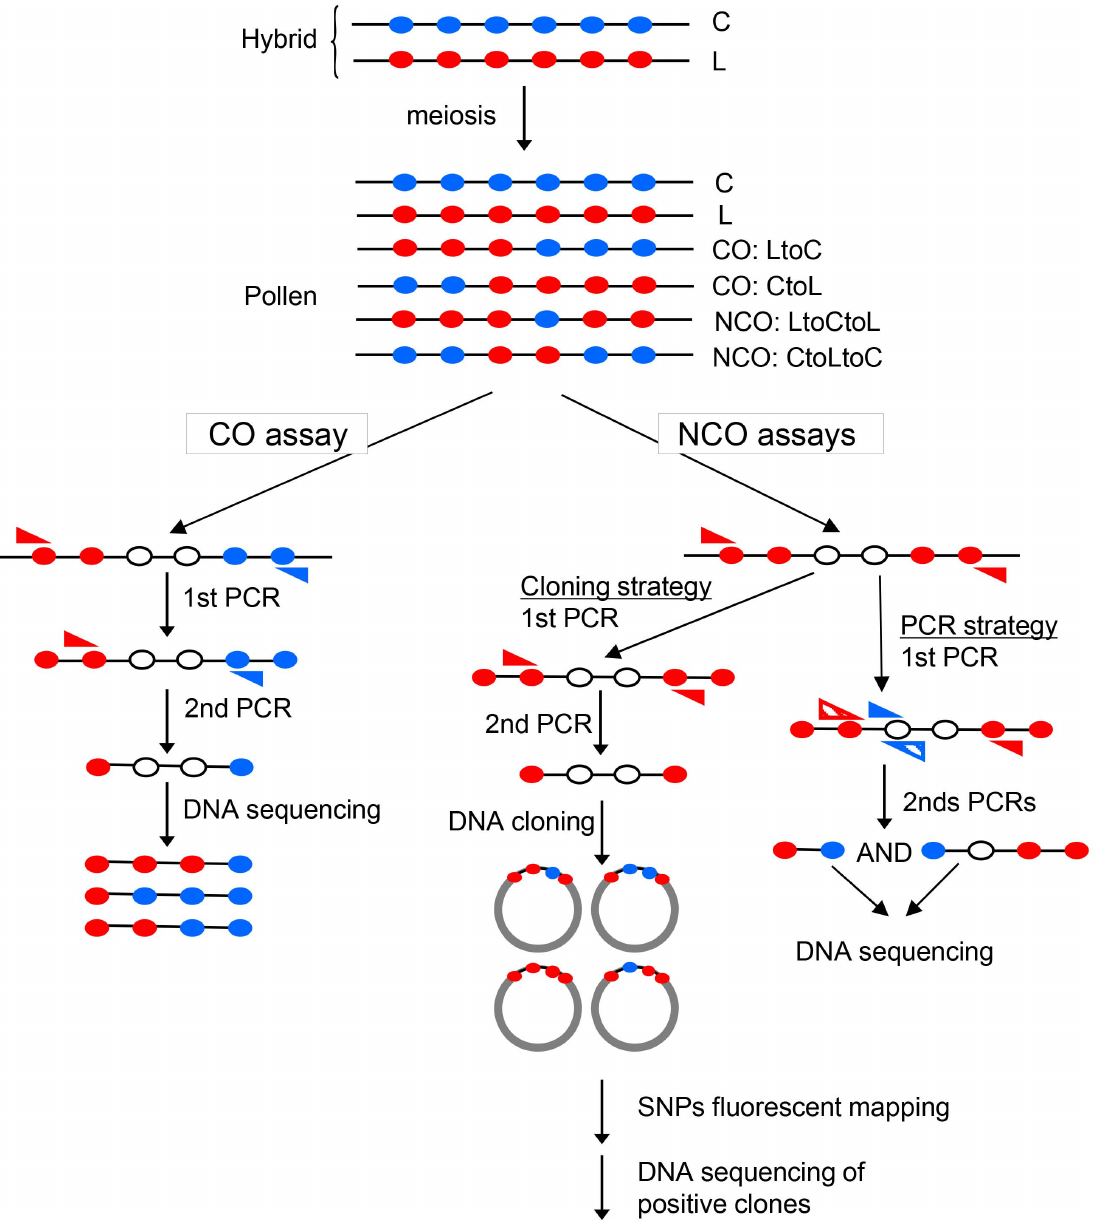
Figure 1. Specific detection of CO and NCO molecules in genomic DNA extracted from pollen. The F1 hybrid contains one allele from each parent at each locus. Filled circles represent polymorphisms on the C (Col, blue) or L (Ler, red) chromosomes. After meiosis, in DNA extracted from pollen, there are either non-recombinant molecules (C, L) or CO (‘LtoC’ or ‘CtoL’) or NCOs (‘LtoCtoL’ or ‘CtoLtoC’) in various proportions depending on the locus studied. To detect CO molecules, two rounds of allele-specific PCR were carried out with allele-specific oligonucleotides (ASOs, blue and red triangles) on pools of genomic DNA. To detect NCO molecules, alleles containing polymorphisms from one specific parent on each side were first amplified by one or two rounds of allele-specific PCR. Then the region of interest was cloned in E.coli and interesting SNPs were genotyped using fluorescent mapping as described [31]. Alternatively, two rounds of complementary allele-specific PCR were performed to analyze the status of interesting SNPs. A NCO event was scored when both PCRs were